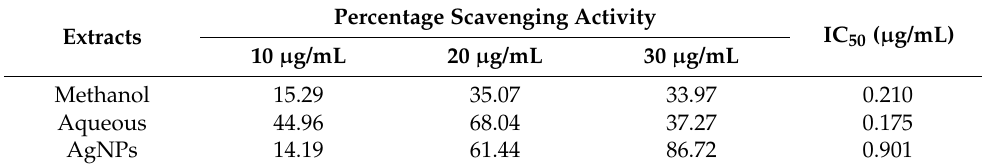
Table 2. Antioxidant activities of A. indica Bark extracts and synthesized